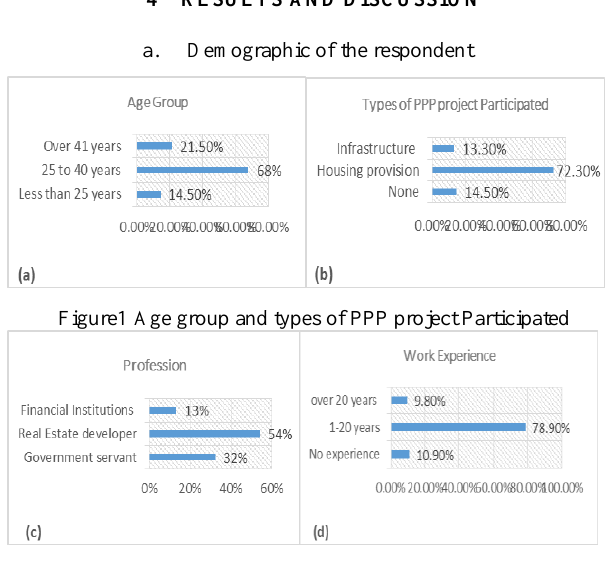
Figure 2 Profession and Work experience